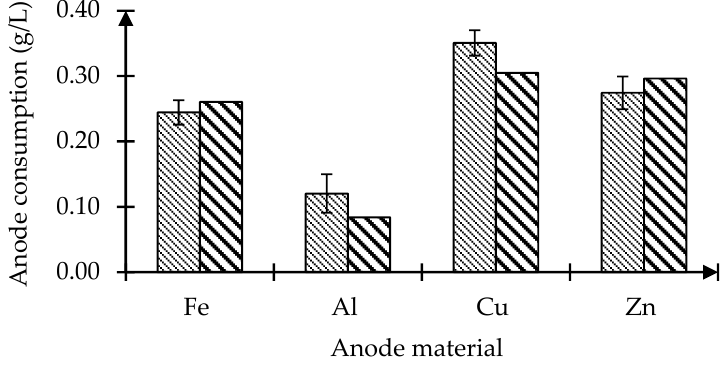
Figure 7. Actual and theoretical anode consumption of different anode materials. Error bars represent the standard deviation ( n = 3).